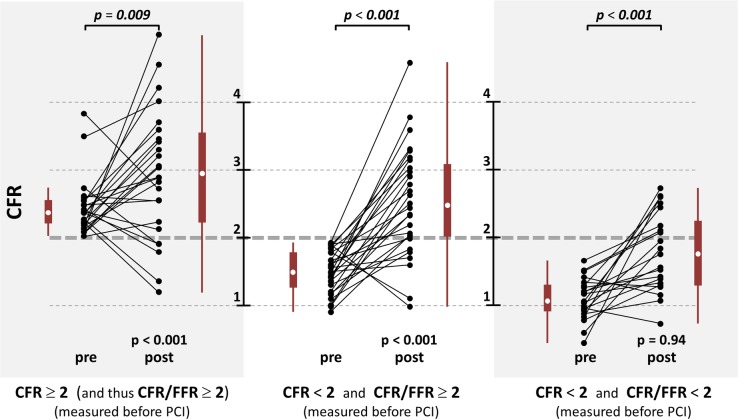
Measured CFR before vs. after PCI.The white dots in the boxplots represent the median values. Non-italicized p values (1st rows) refer to the one-sample right-tailed t-tests with the alternative hypothesis that post-PCI-CFR mean was greater than 2. Italicized p values (top) refer to the one-sample right-tailed t-tests with the alternative hypothesis that post-PCI-CFR mean was greater than pre-PCI-CFR mean.